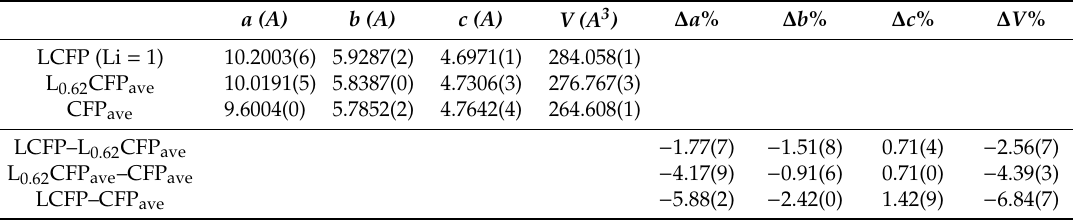
Table 2. Average lattice parameters and their di ff erences between the three